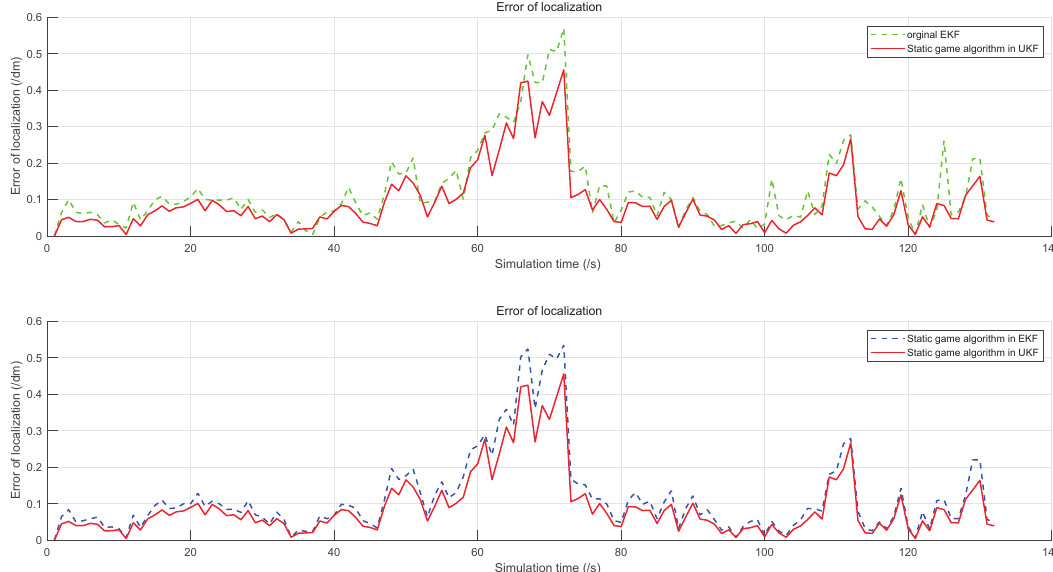
Figure 8. The error of localization on the game theory UKF, the original extended Kalman filtering (EKF), and the game theory EKF.